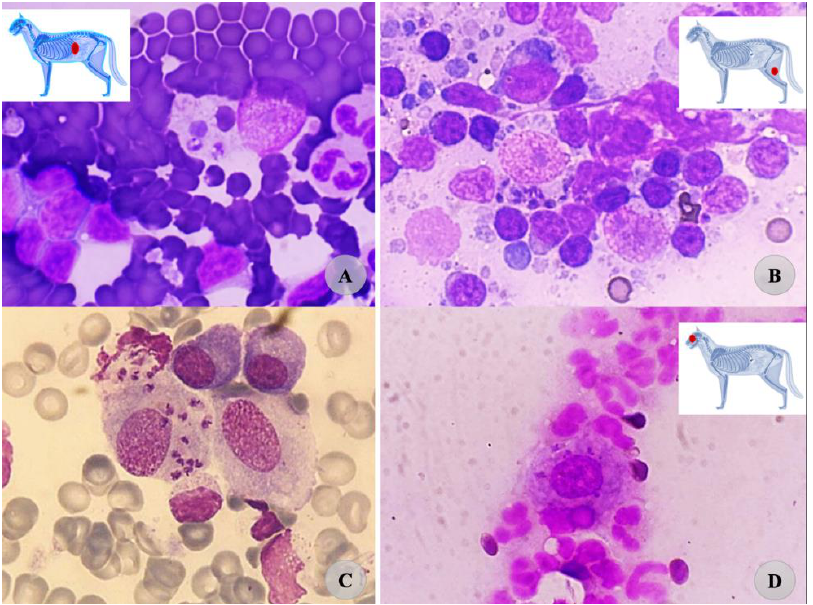
Figure 3. Presence of Leishmania amastigotes in macrophages collected through ( A ) FNA of spleen or ( B – D ) popliteal lymph node or through ( D ) swabs from ocular lesions. ( B – D ) popliteal lymph node or through ( D ) swabs from ocular